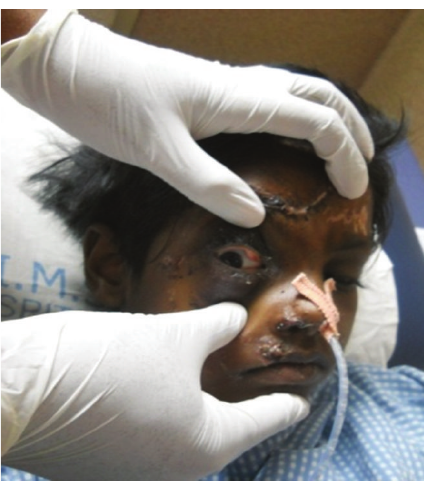
Figure 1: Subconjunctival hemorrhage, circumorbital ecchymosis, and horizontal ocular dystopia involving the right eye.